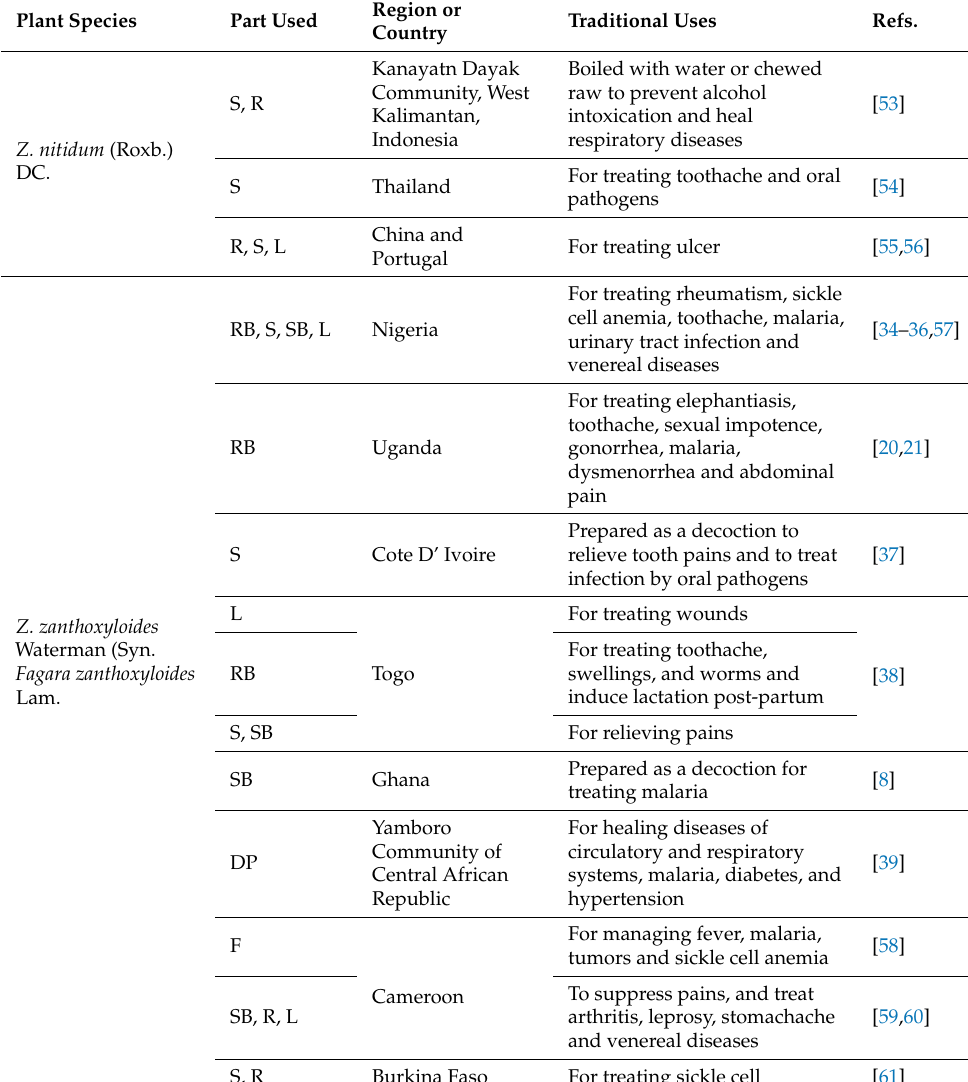
Table 1. Ethnobotanical applications of Zanthoxylum species around the world. Plant Species Part Used